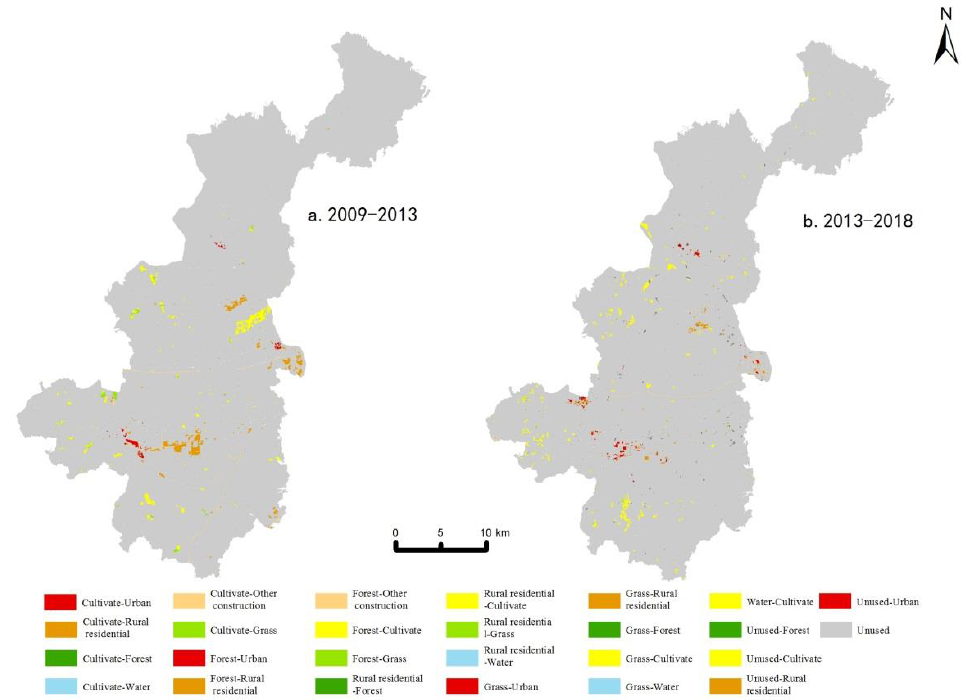
Figure 3. Land use change in Yujiang District from 2009 to 2018.